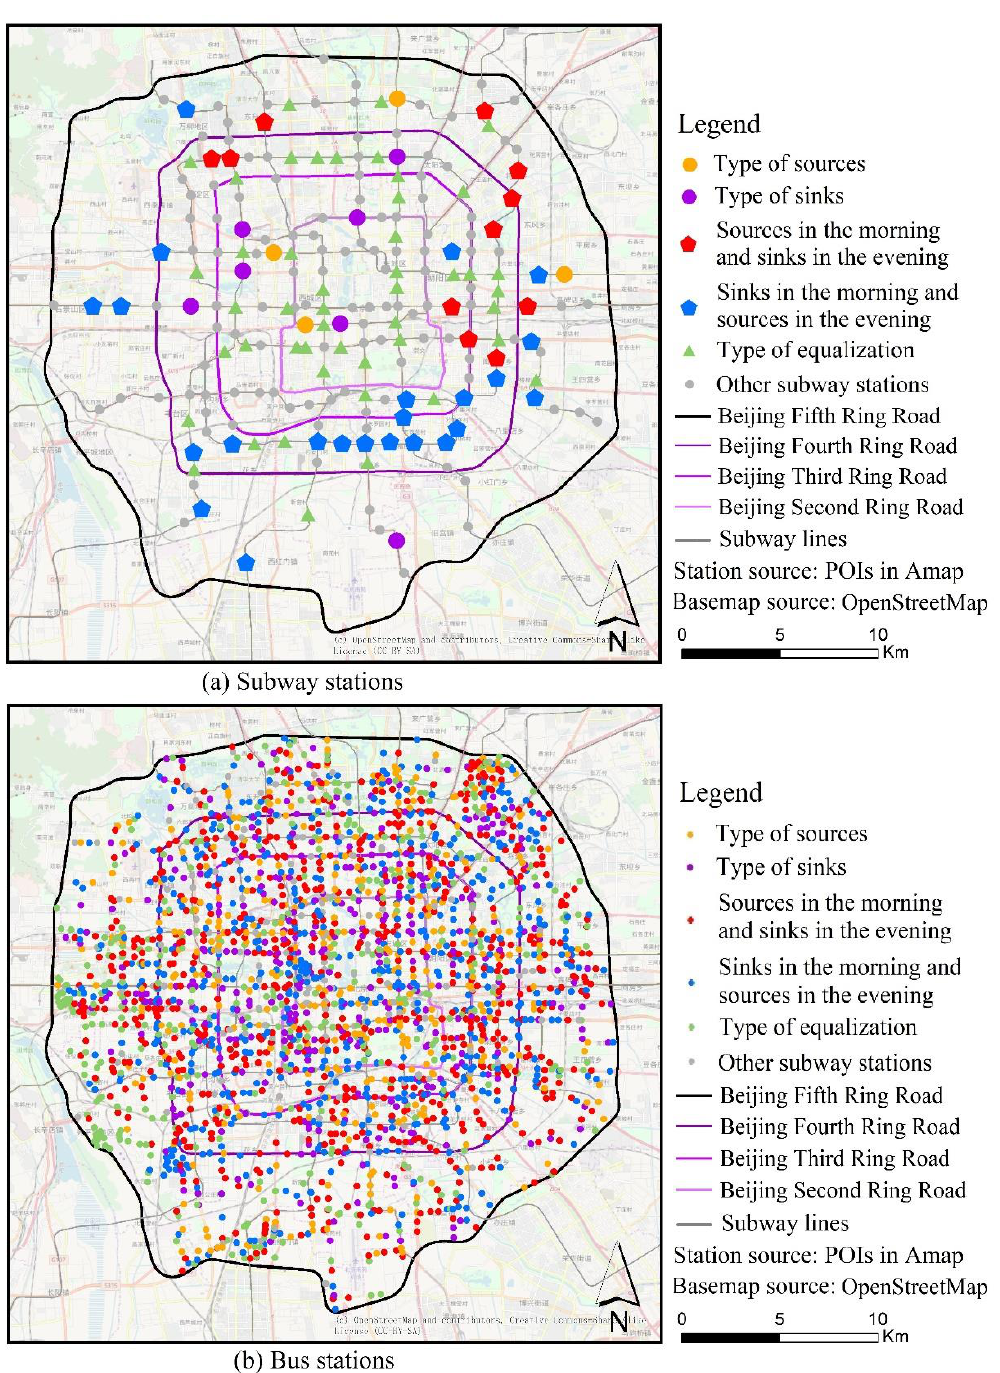
Figure 9. Classification of the subway and bus stations according to the sink-source characteristics of the shared